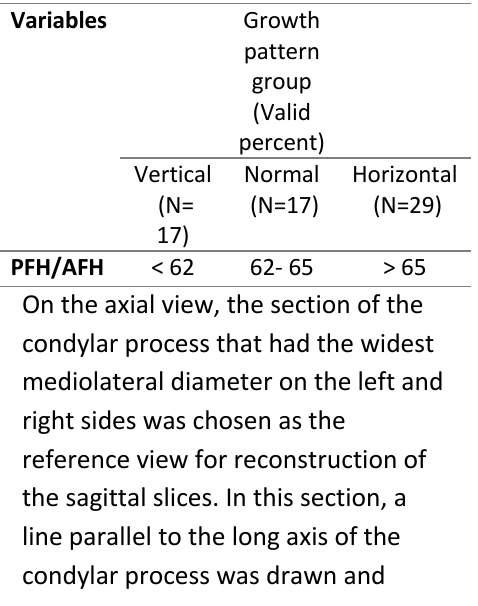
Table 1. Distribution of subjects according to different growth